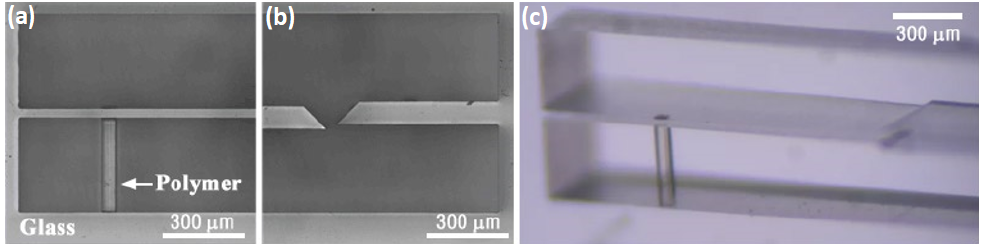
Figure 9. ( a – c ) Example of a hybrid microfluidic device